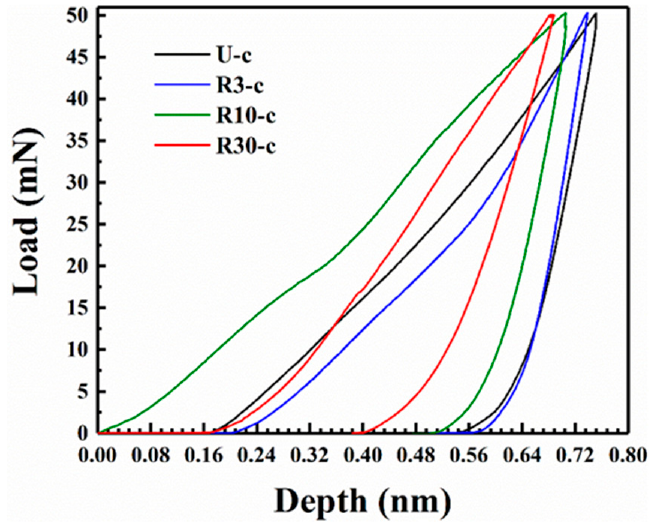
Figure 8. Characteristic nanoindentation curves load vs. depth, for U- and R-c samples. Table 2. Nanoindentation values for the set of the experimental sintering process. Sample